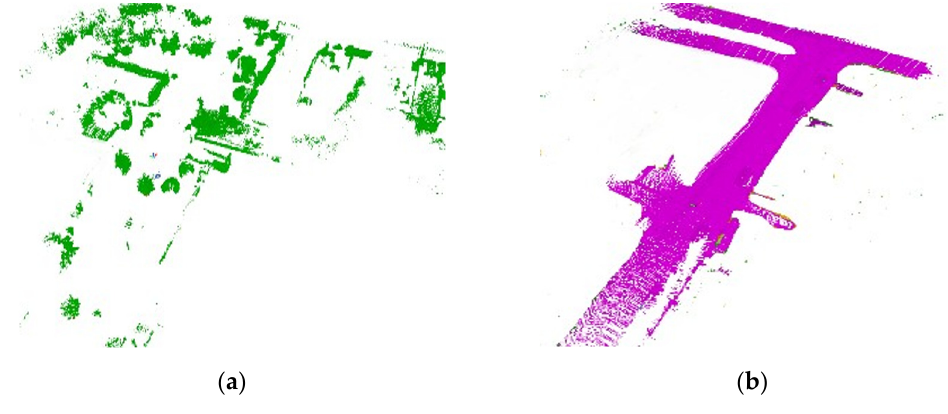
Figure 18. Point cloud extraction: ( a ) vegetation; and ( b ) road.